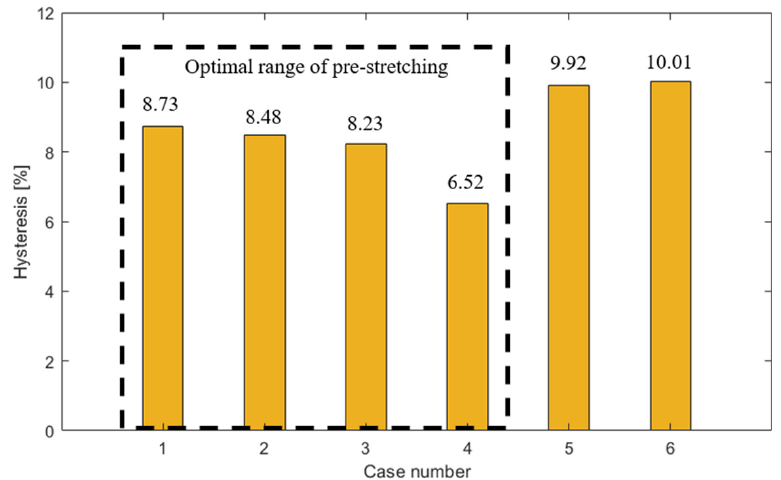
Figure 8. Optimal pre-stretching experiment results.